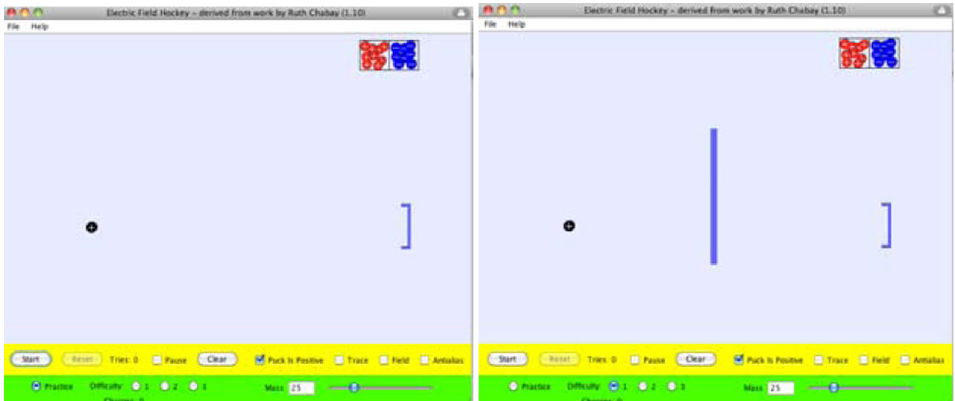
FIG. 2. Screenshots of the Electric Field Hockey game. Left: The Practice setting. Right: Difficulty 1